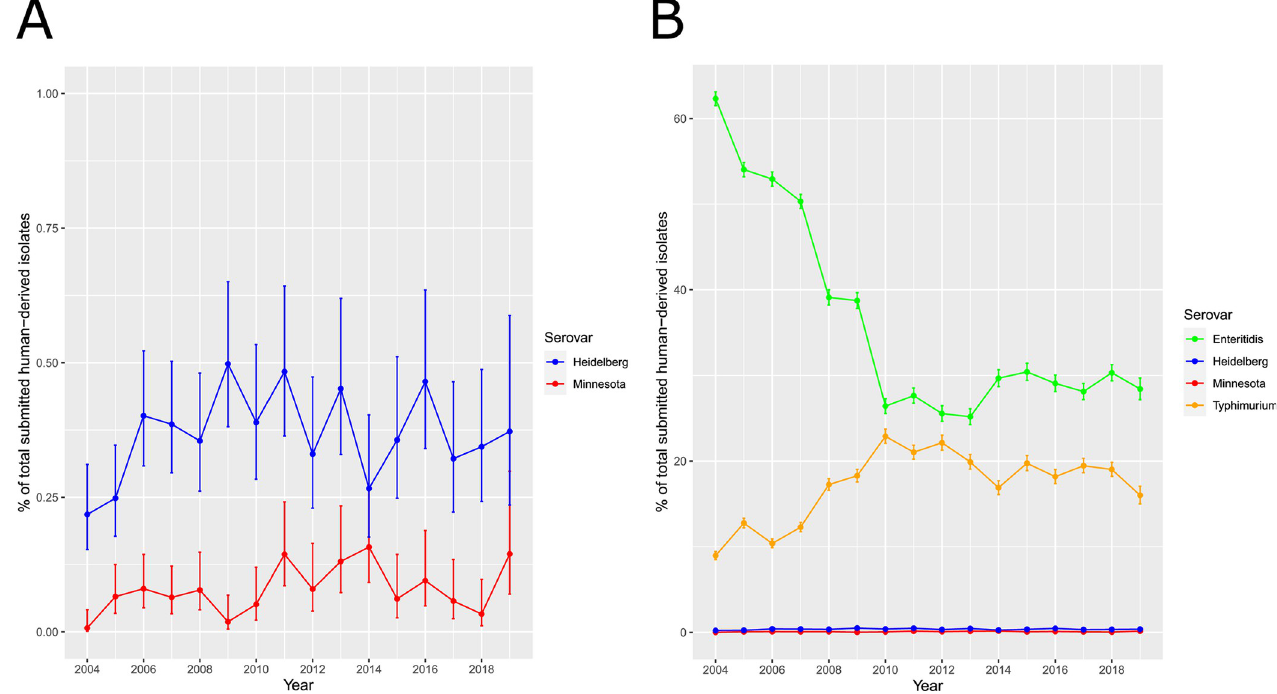
Fig 4. UKHSA Salmonella Heidelberg and Salmonella Minnesota trends in human salmonellosis cases in England and Wales. (A) Percentage over time of Salmonella Heidelberg and Salmonella Minnesota. (B) Percentage over time of four serovars causing salmonellosis in England and Wales.